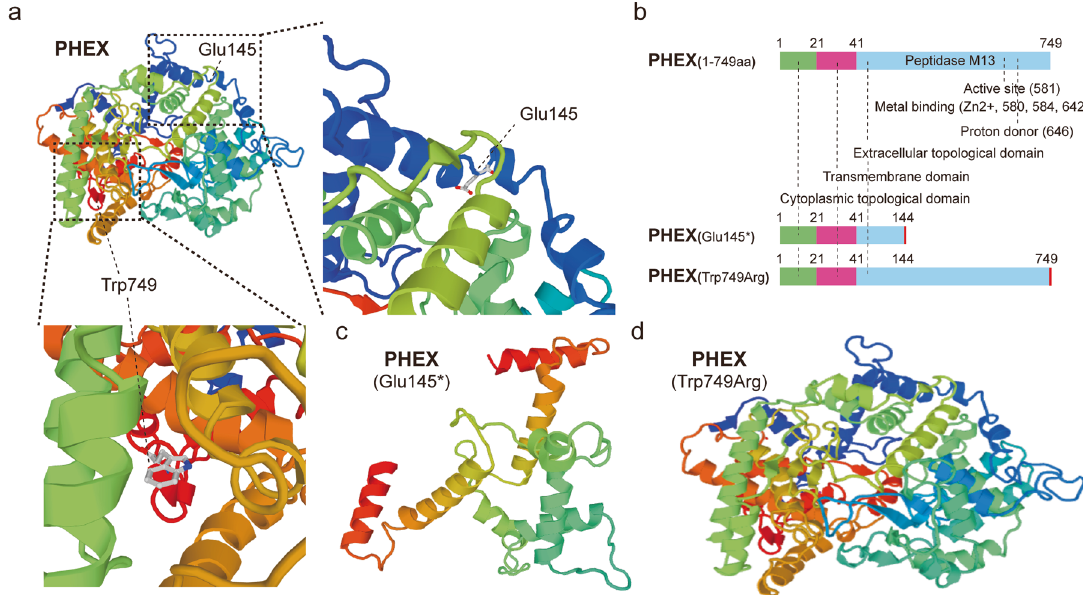
Fig. 6 The structure prediction map of PHEX protein mutant. a three-dimensional crystal structure map of PHEX protein and the location of mutation sites (dmam SwissMe model database, URL: https://swissmodel.expasy.org/repository/uniprot/P78562). b the functional domain map of PHEX protein and its variants. c , d prediction and comparison of the three-dimensional structure of normal PHEX and Glu145* mutation and Trp749Arg mutation using Swiss-model. (URL: https://swissmodel.expasy.org/repository/uniprot/P78562).